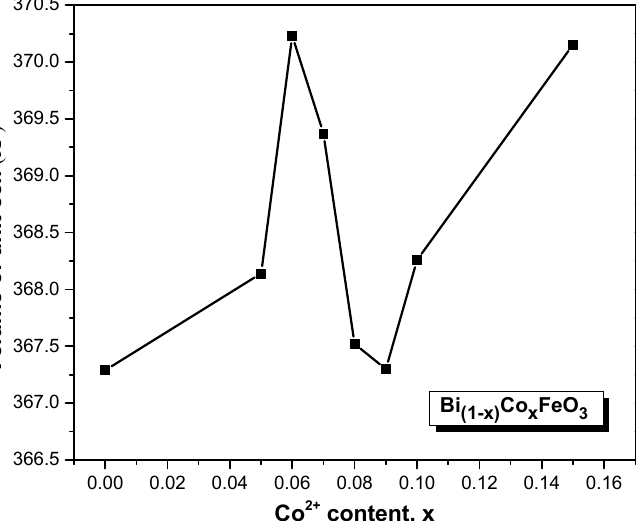
Figure 3. Effect of Co 2+ ions content on the volume of unit cell of BiFeO 3 powders thermally annealed at 700 °C for 30 min.